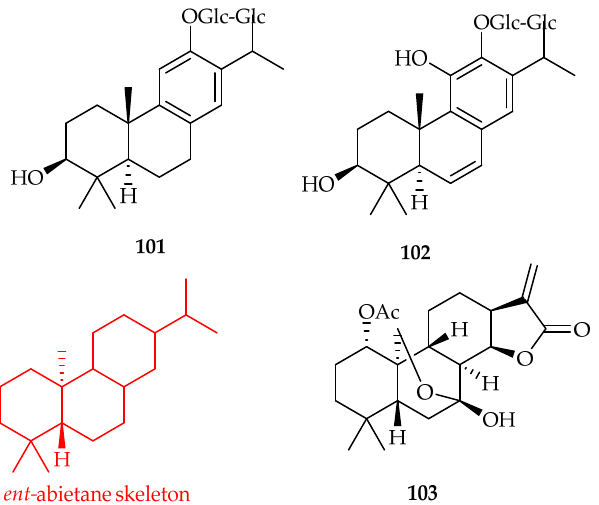
Figure 42. Structures of perovskiaditerpenoside A 101 [64], perovskiaditerpenosides C 102 [64], and serrin K 103 [65]. serrin K 103 [65].